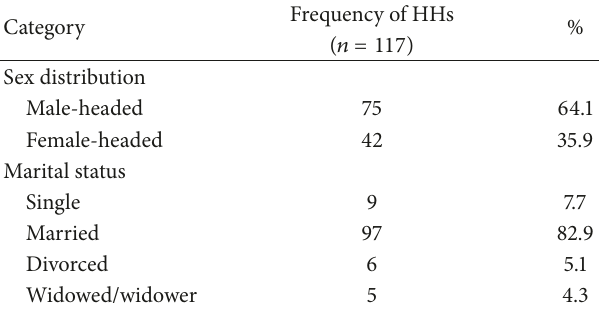
Table 2: Educational level of the respondent household heads in the study area.